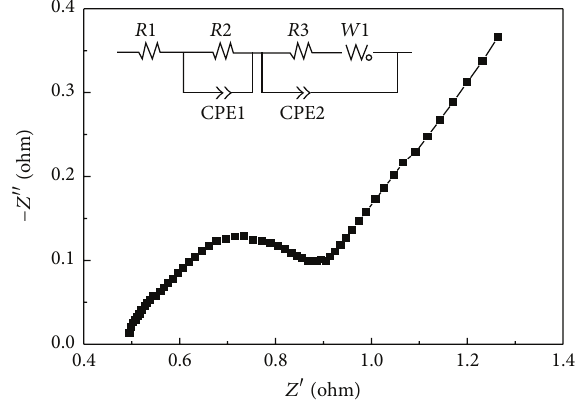
Figure 5: EIS of La 0.96 Ce 0.04 Mg 0.15 Al 0.05 Ni 2.8 alloy electrode at 50%